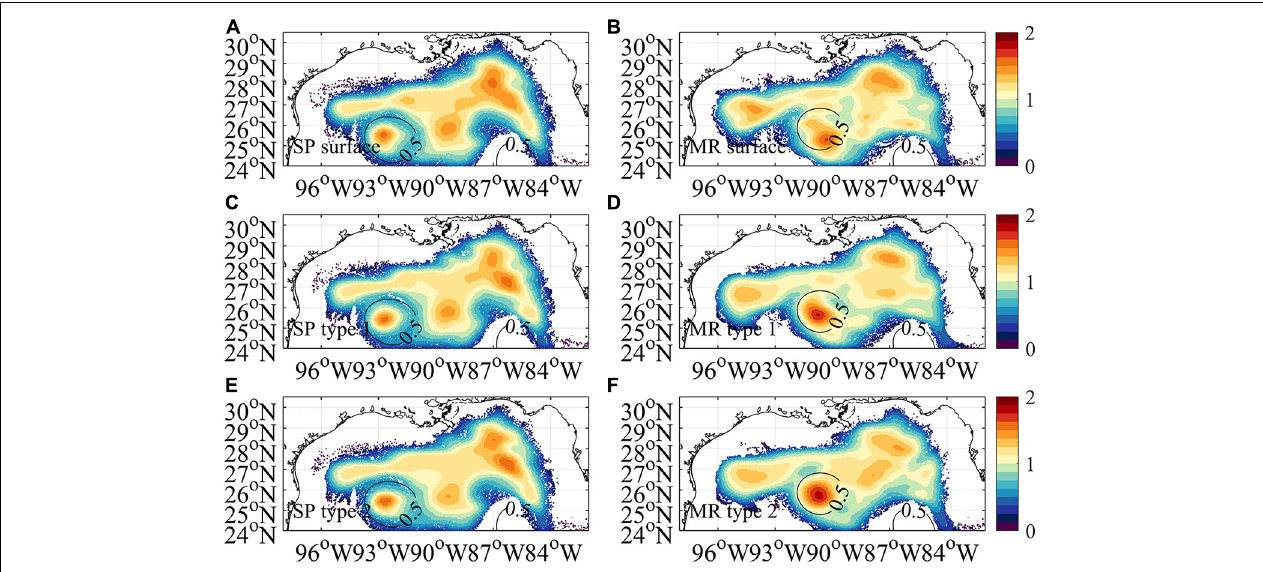
FIGURE 7 | Horizontal distributions of the 2-dimensional KDE of all particles (from all ensembles) after 10 days since their release in SP (A,C,E) and MR (B,D,F) simulations. The type of release is indicated in each subplot. The KDE is normalized to indicate a homogenous distribution at KDE = 1.